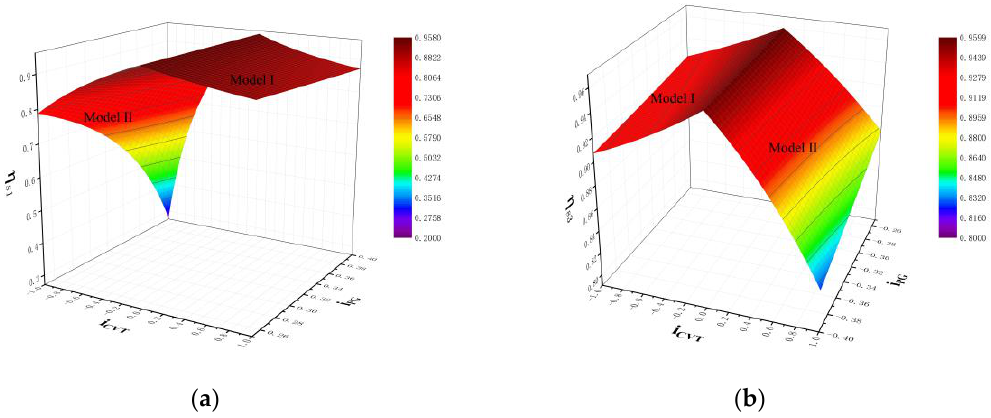
Figure 15. The efficiency curves of Schemes 1 and 3: ( a ) Scheme 1; ( b ) Scheme 3. Figure 15. The e ffi ciency curves of Schemes 1 and 3: ( a ) Scheme 1; ( b ) Scheme 3.